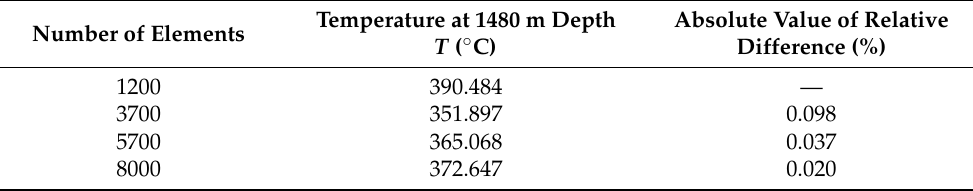
Figure A2. Simulated temperature and flow vectors for ( a) scenario 2A at time 800,000 years and ( b ) scenario 2B with a dipping angle of faults equal to 60° at time 800,000 years. The direction of flow is from the point to the end of straight lines. The length of each line indicates the water vector magnitude, where 1.2 km = 10 −6 g s −1 cm −2 . Table A1. Verification of mesh independence for simulation of scenario 1 at the location of geothermal A6